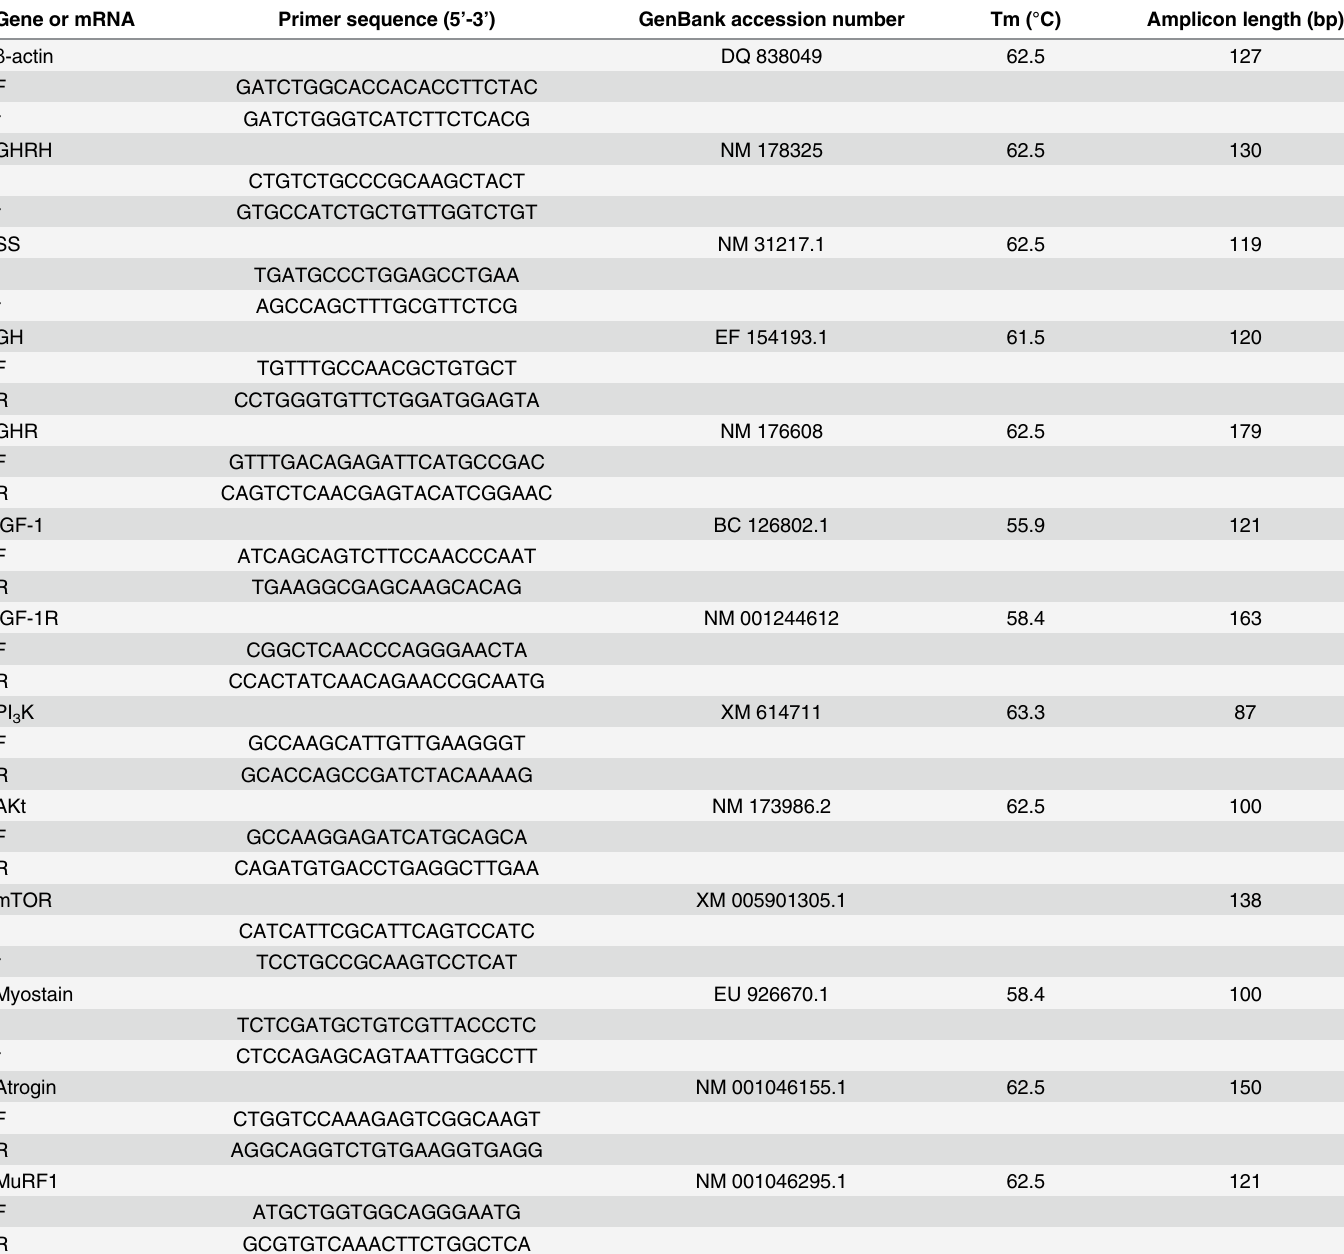
Table 1. Information for primers used in the